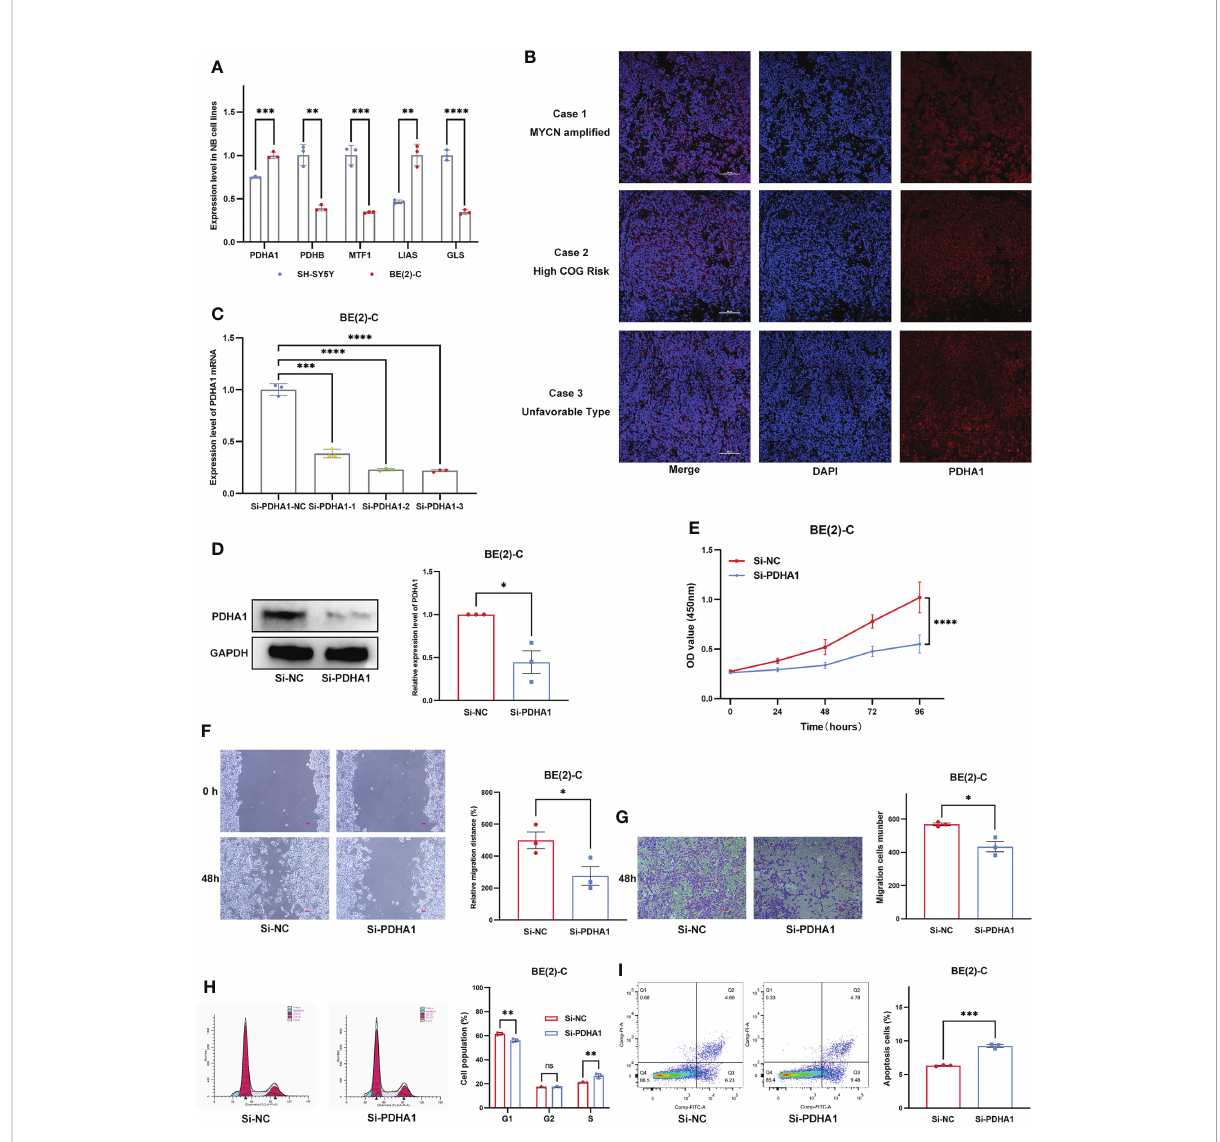
FIGURE 11 Expression Validation and Functional Validation. (A) Expression of fi ve Riskgenes between SH-SY5Y and BE(2)-C cells. (B) Expression of PDHA1 protein in clinical samples. (C) qRT-PCR analysis of PDHA1 expression in NB cells after transfection with siRNAs. (D) Western blot analysis of PDHA1 expression in NB cells after transfection with siRNA-3. (E – G) Silencing of PDHA1 suppressed proliferation, invasion, and migration in NB cells. (H,I) Silencing of PDHA1 promoted cell cycle arrest at the S phase and apoptosis in NB cells. *, **, ***, and **** indicate a signi fi cance level of 0.05, 0.01, 0.001, and 0.0001,